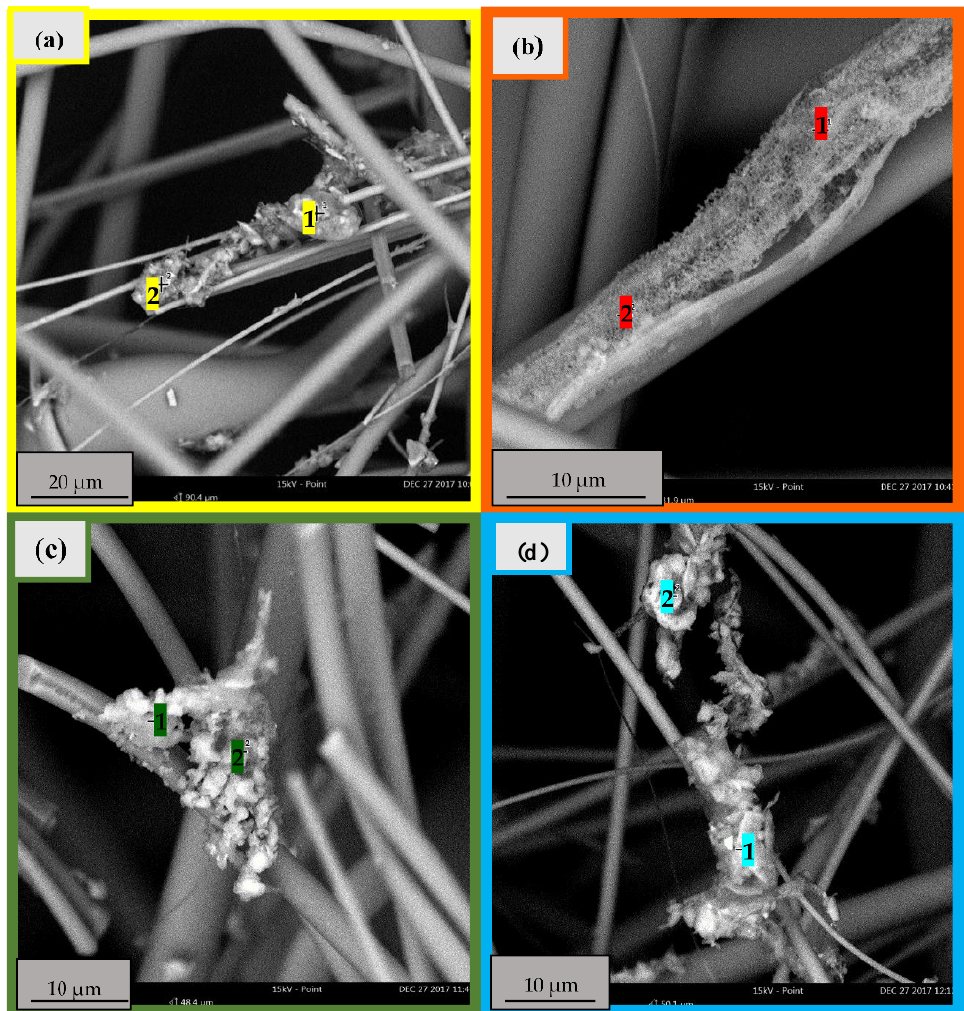
Figure 5. SEM-EDX spot analysis of uncalcined and calcined ceramic papers at different temperatures: ( a ) U-3.2, ( b ) U-3.2-600, ( c ) U-3.2-650, and ( d ) U-3.2-700. Numbers indicate the zones where EDX spectra were acquired. Table 4. EDX analysis of ceramic papers calcined at different temperatures (Figure 5).